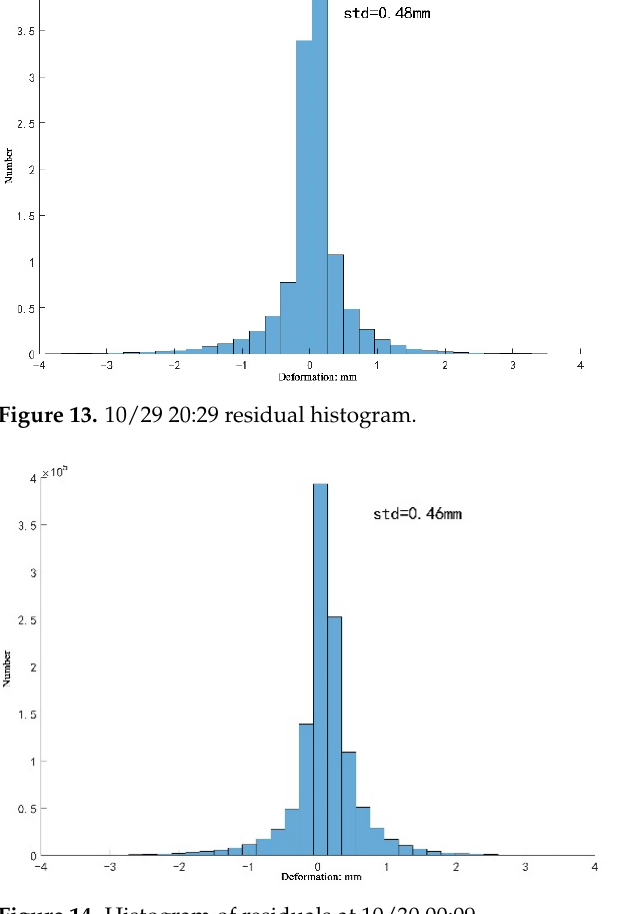
Figure 14. Histogram of residuals at 10/30 00:09.